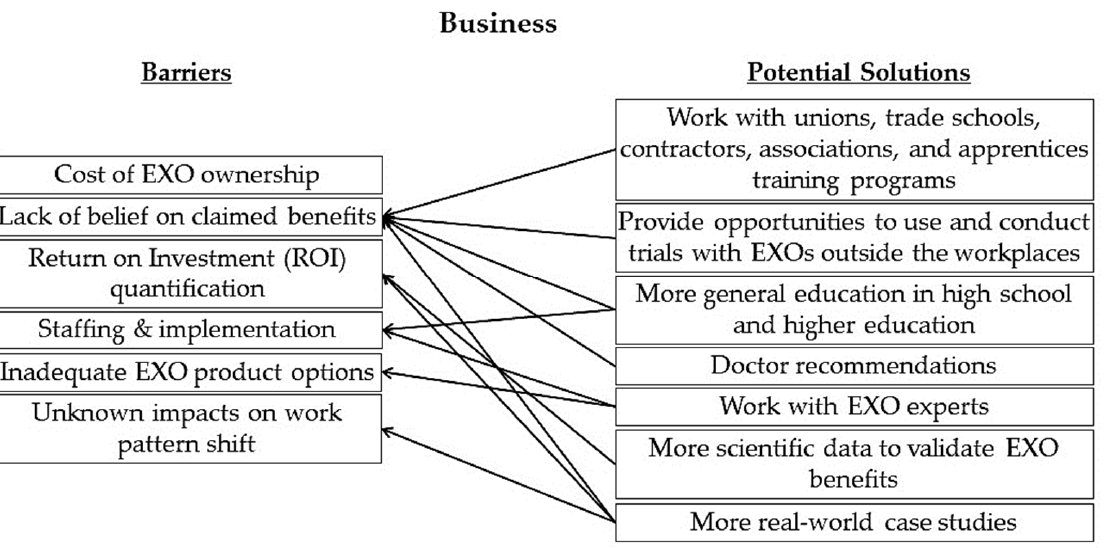
Table 4. Summary of technology category outcomes.